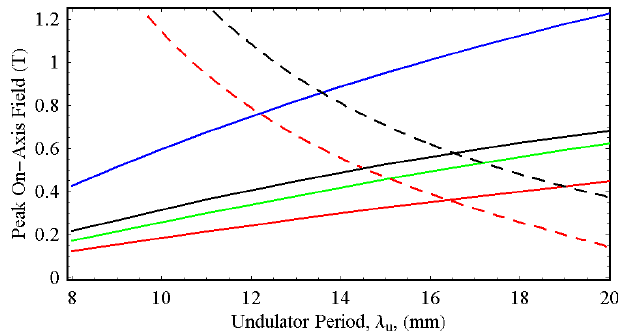
FIG. 3. (Color) Computer modeled peak on-axis magnetic field for APPLE-II (solid, red), APPLE-III (green), multimode (solid, black) undulators in circular polarizing mode and for the PM ring undulator (blue) vs undulator period length. The field/period length required to produce 10 MeV photons with 150 GeV electron beam (dashed, red) and 20 MeV photons with a 250 GeV beam (dashed, black) at the first harmonic is also